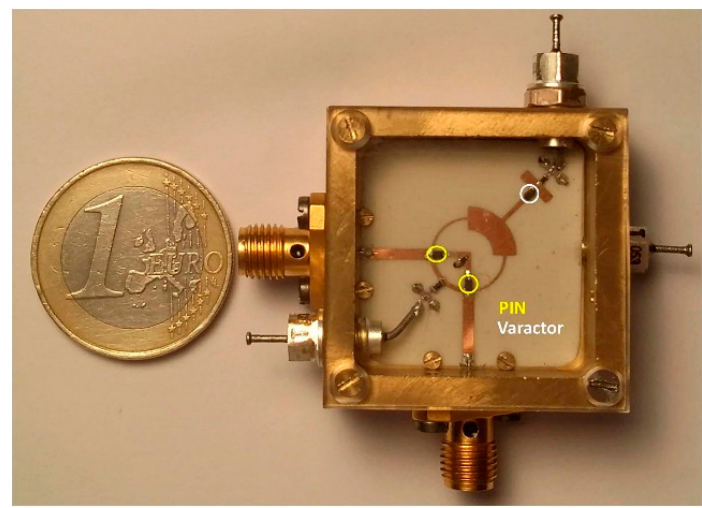
Figure 14. The UWB reconfigurable filter [63].